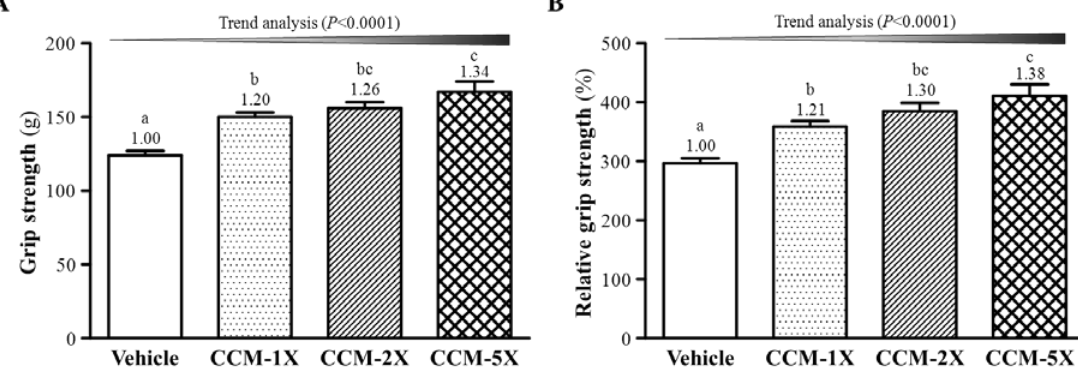
Figure 2. Effect of CCM supplementation on forelimb grip strength. ( A ) grip strength; ( B ) relative grip strength. Data are mean ± SEM for n = 10 mice in each group. Different letters indicate significant difference at p < 0.05 by one-way ANOVA. Low-dose (CCM-1X), medium-dose (CCM-2X) and high-dose (CCM-5X) CCM at 12.3, 24.6 and 620 mg/kg/day, respectively.